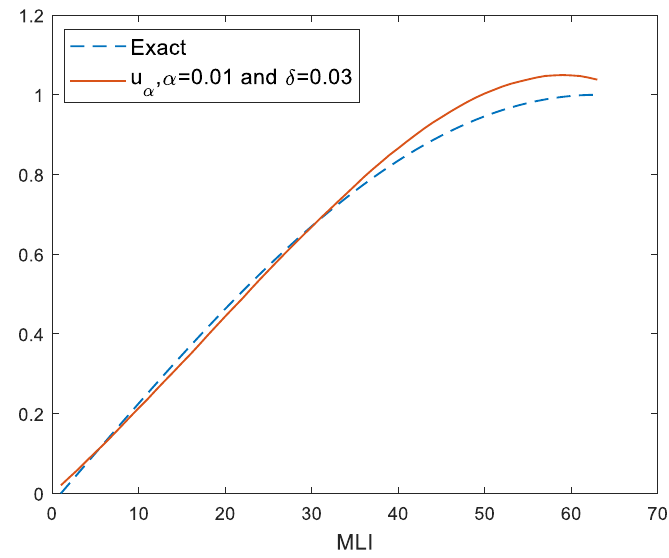
Figure 1. Approximation solution by MLI. Algorithm 2 CLI (number of iteration) : the value of regularization parameter with 1000 iterations (see Figure 2).